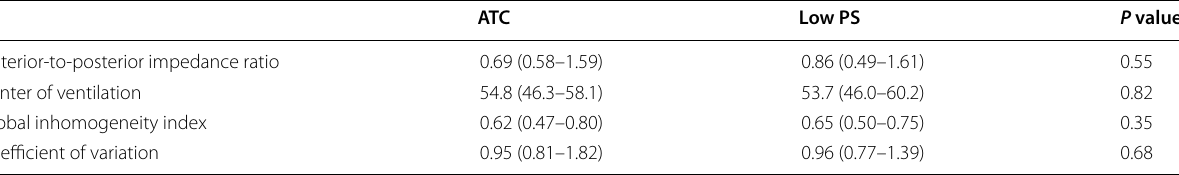
Values are median (1st–3rd quartiles)